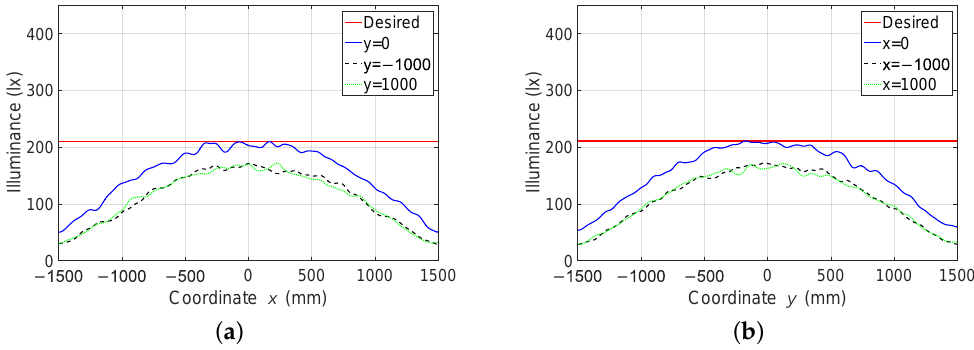
Figure 20. Illuminance distribution curves of the three profiles found using genetic algorithm: ( a ) on the coordinate axis x and ( b ) on the coordinate axis y